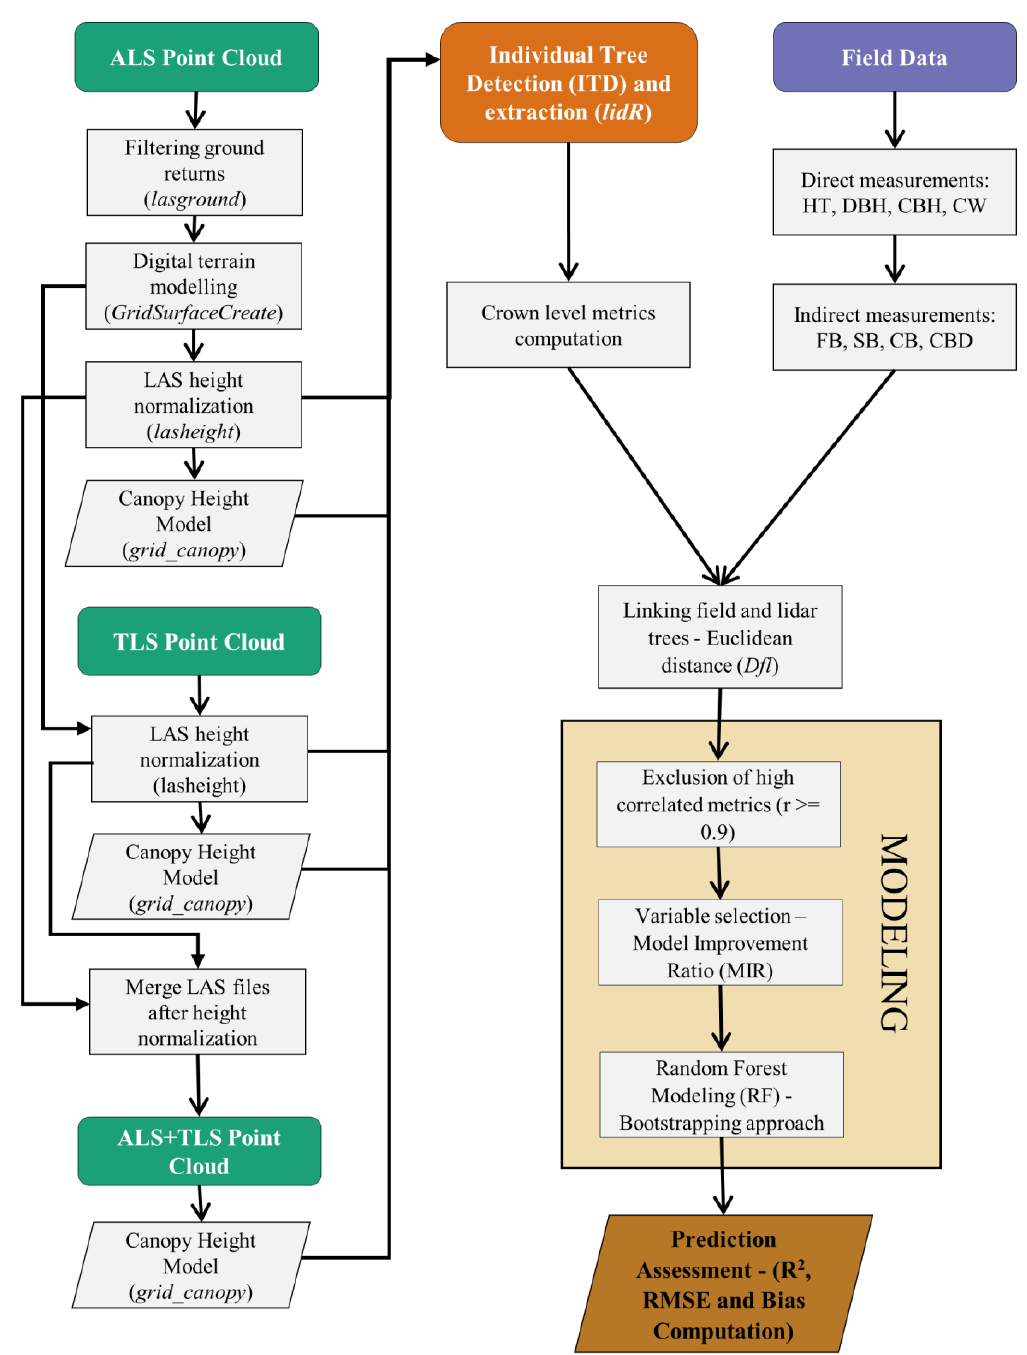
Figure 2. Overall workflow for data processing, individual tree detection and extraction, modeling, and prediction